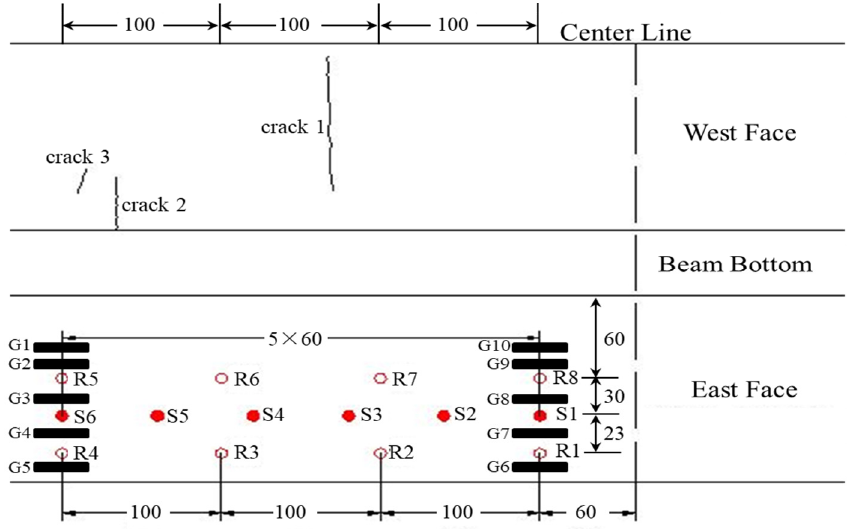
Figure 5. Schematic layout of the transducers and gauges networks (unit: cm ).